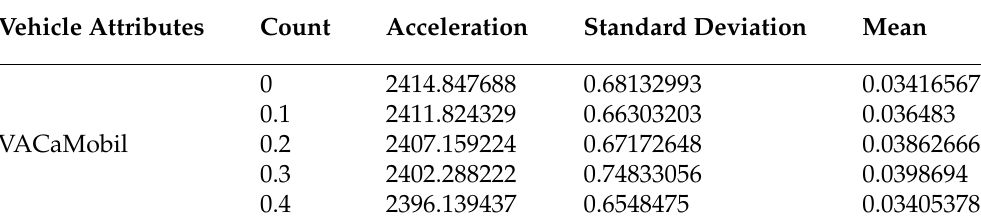
Table 6. Traffic